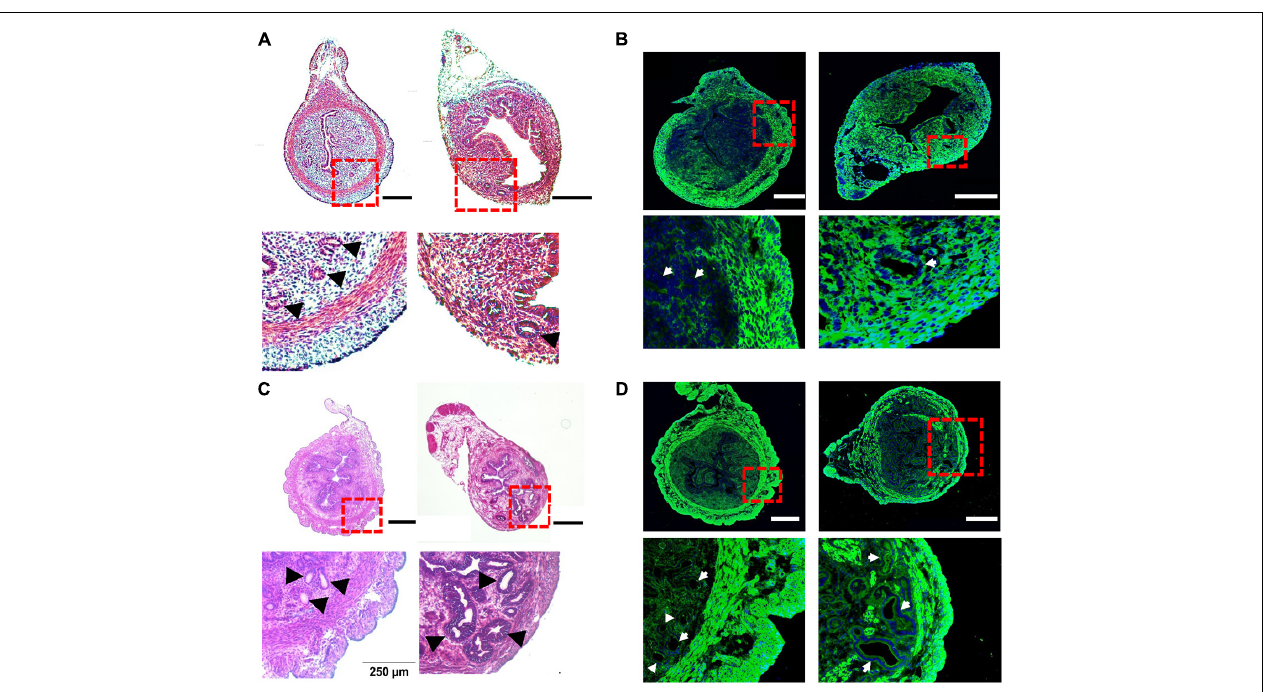
FIGURE 2 | Histological characteristics of tamoxifen-induced adenomyosis in neonatal and adult mice. (A) The hematoxylin–eosin ( H–E) staining of uterine cross-sections from postnatal day (PND) 14 mice after treatment with the vehicle for preparing tamoxifen (left) or with tamoxifen (right). Insets in (A) and other panels in this figure are enlarged areas in dotted red line boxes. (B) The immunostaining of Myh11 (green) in uteri from PND14 mice after treatment with the vehicle (left) or with tamoxifen (right). The nucleus, shown in blue in this panel (and in panel D ), was stained with DAPI. (C) The H–E staining of uterine cross-sections from PND55 mice after treatment with the vehicle (left) or with tamoxifen (right). (D) The immunostaining of Myh11 (green) in uteri from PND55 mice after treatment with the vehicle (left) or with tamoxifen (right). Note that (1) glands as marked by black arrowheads (A,C) or white arrows (B,D) were present in the circular smooth muscle in both PND14 and PND55 mice after tamoxifen treatment, but they were absent in vehicle control mice of both ages, and (2) circular muscle in both PND14 and PND55 mice were intact without interruption in vehicle control mice but were disrupted by endometrial glands in mouse uteri treated with tamoxifen. N = 4–6 mice. Scale bar: 200 µ m (A,B) ; 500 µ m (C,D) .